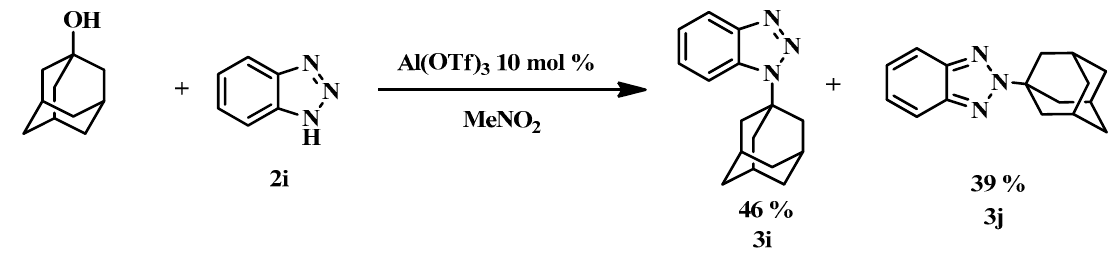
Figure 6. Adamantylationof